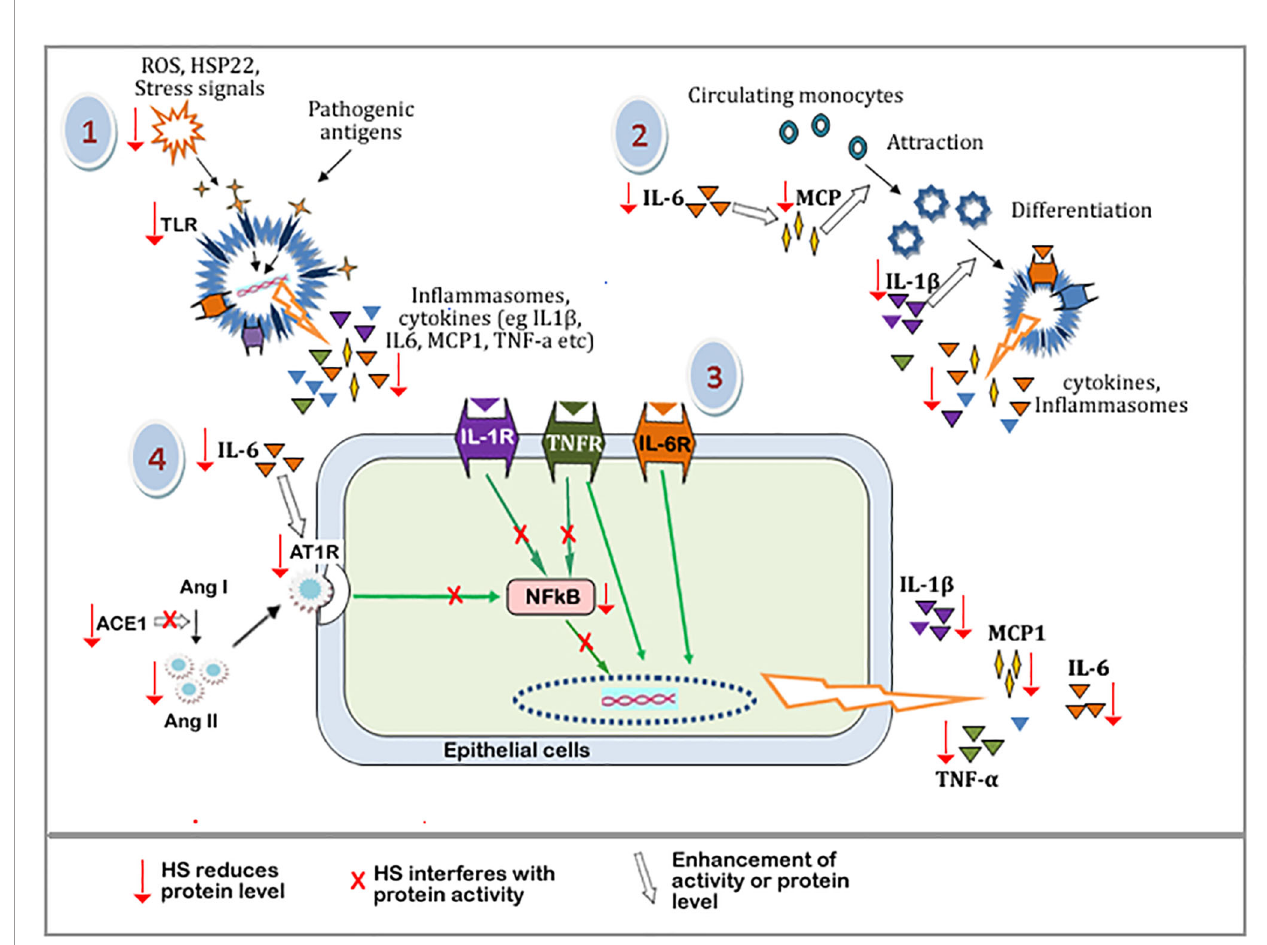
FIGURE 14 | Schematic diagram showing the tentative mechanism of HS anti-in fl ammatory activities. Oxidative stress and other cellular damage cause the activation of TLRs, which leads to the expression of in fl ammatory mediators. These mediators further perpetuate immune responses causing the release of more in fl ammatory mediators. HS interferes with various steps along these pathways (shown by red arrow). Steps with a red arrow indicate that HS reduced the level of the component of that step. Steps with a red “ X ” means that HS inhibited or interfered with the protein activity along that pathway. The white arrow means that the activity or level of a component is enhanced.\ TLRs, Toll-like receptors; ROS, Reactive oxygen species; HSP22, heat shock protein 22; IL-6, Interleukin 6; IL-1b, interleukin 1b; MCP-1, Monocyte Chemoattractant Protein-1; NFkB, Nuclear factor kappa B; IL-1R, Interleukin 1 receptor; TNFR, tumor necrosis factor receptor; IL-6R, Interleukin 6 receptor; Ang I, Angiotensin I; Ang II, Angiotensin II; ACE-1, Angiotensin converting enzyme 1; AT-1R, Angiotensin II type 1